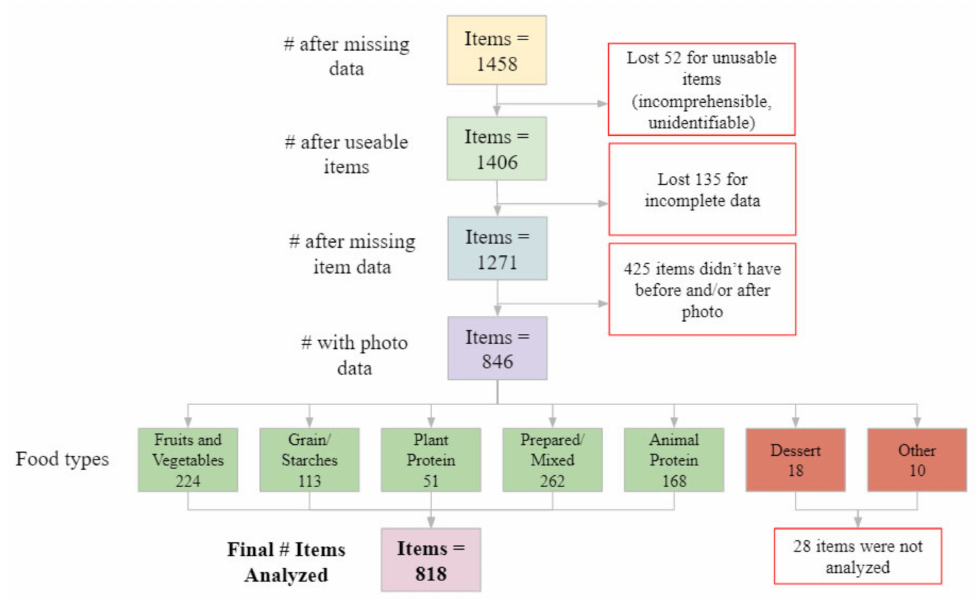
Figure 3. Flow chart with the starting and final number of items analyzed after excluding items with missing and incomplete